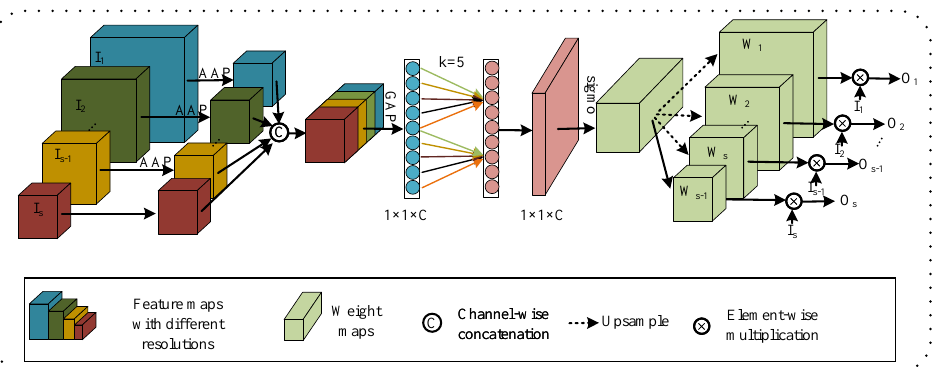
Figure 3. The structure of CWU. The input feature map of the parallel multi-resolution branch is subjected to the adaptive average pooling (AAP) operation to make its resolution equal to the minimum resolution of the branch and concatenated in the channel direction. Then, global average pooling (GAP) is performed to compress the spatial features of the input feature map, and the compressed feature maps are subjected to a one-dimensional convolution operation to learn the importance of different channels.